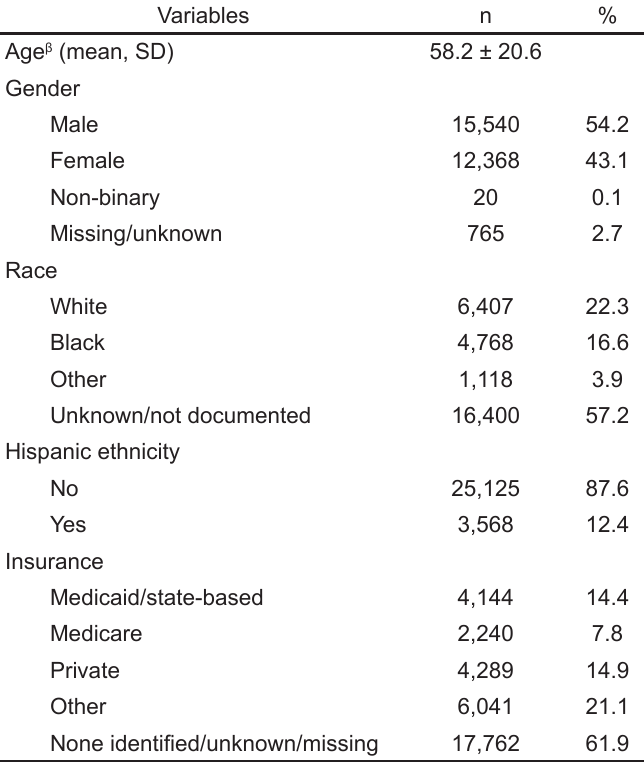
Table 1. Patient population demographics (n =